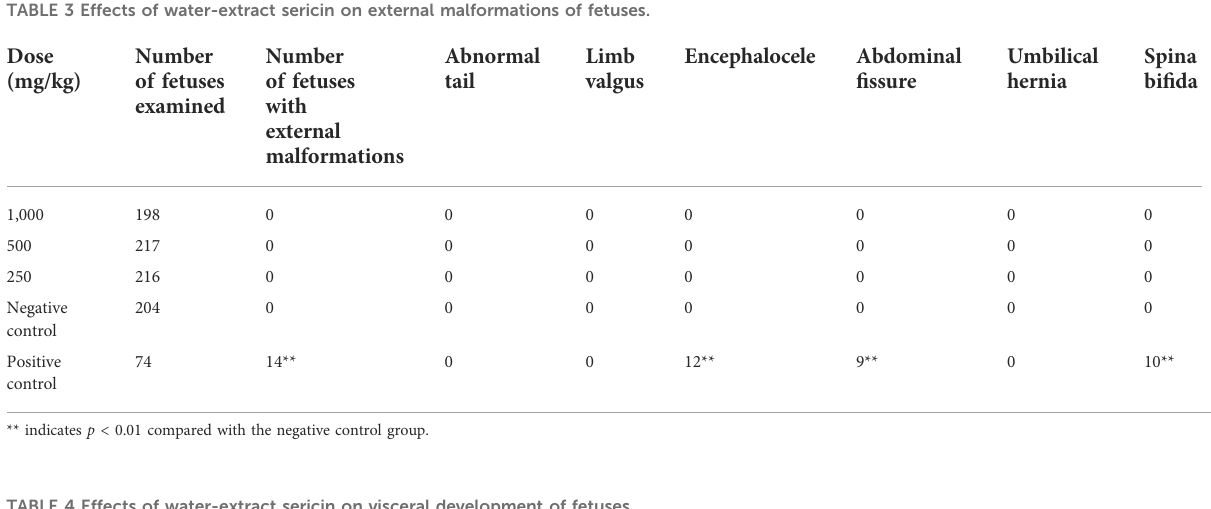
TABLE 4 Effects of water-extract sericin on visceral development of fetuses.